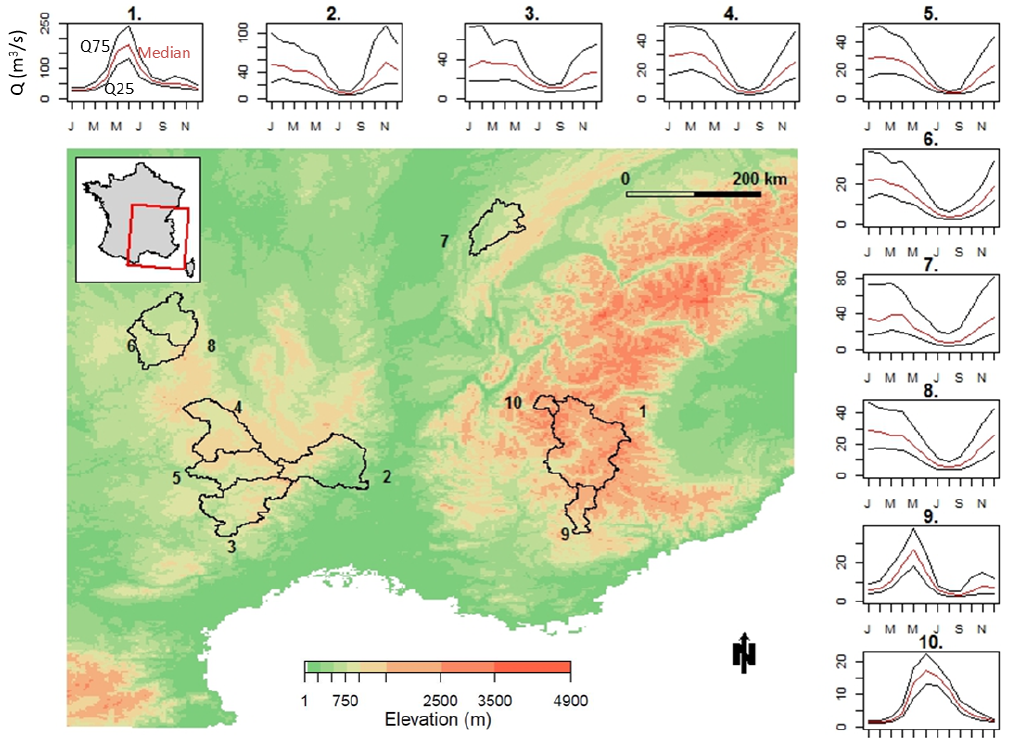
Figure 1. Location and hydrological regimes of the 10 studied catchments in France. Lines represent the 75th (upper black line), 50th (central red line) and 25th (lower black line) percentiles of interannual daily flows (in m 3 s − 1 ), evaluated with observed streamflow data available for the period